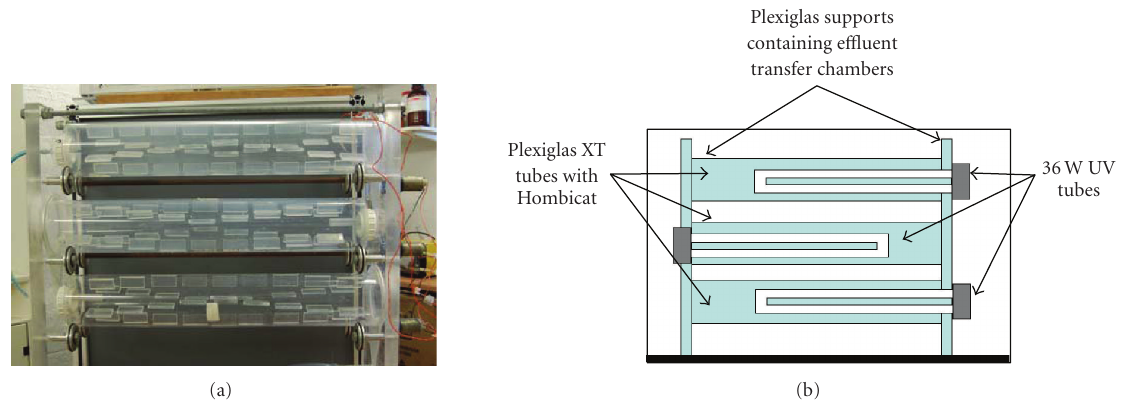
Figure 4: (a) Photocatalytic reactor drum setup with patented paddle design [20] and (b) drum reactor configuration in UV box.